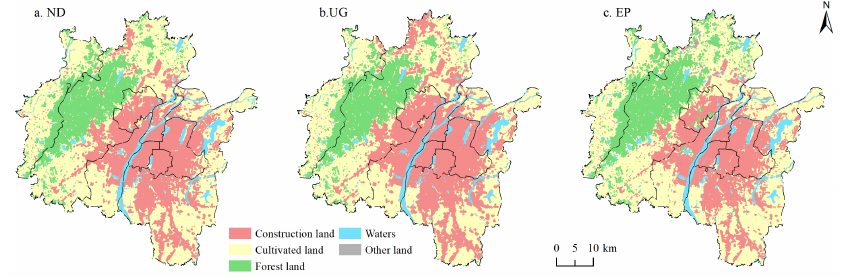
Figure 4. Simulation results of land use in the study area in 2025 under multiple scenarios. ND: natural development; UG: urban growth; EP: ecological protection. Table 3. Multi-scenario simulation results of land-use change in the study area (2018–2025; km 2